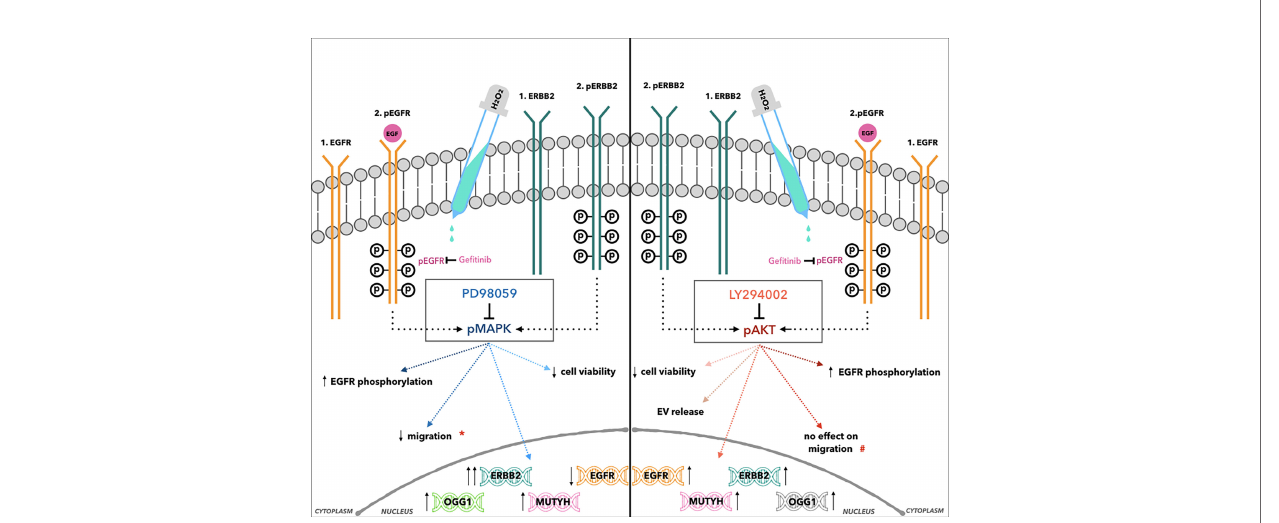
FIGURE 8 | Cartoon illustration of the effects of H 2 O 2 treatment combined with MAPK (left, central box: PD98059) and AKT inhibitors (right, central box: LY294002) in AGS cells. *Indicates the reduction of cell migration after H 2 O 2 co-treatment compared to PD98059 alone. #Indicates the reduction of cell migration only after LY294002 alone